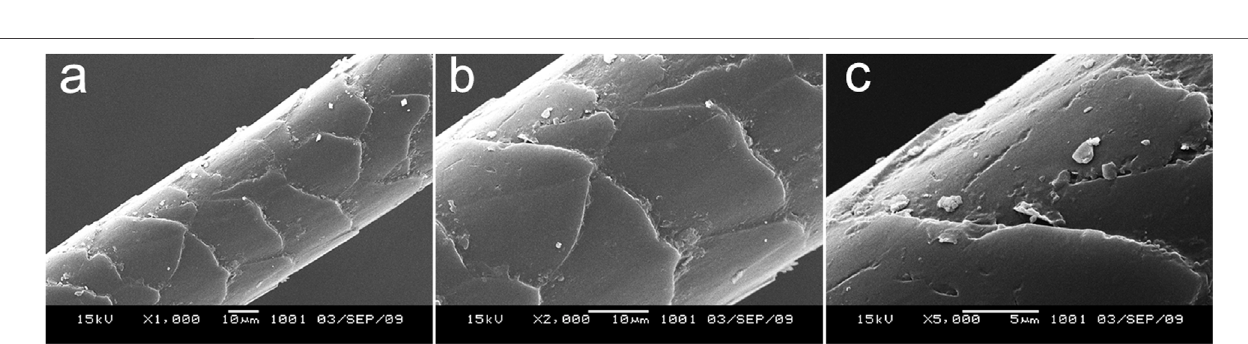
FIGURE 2 | Polar bear hair surface structure by SEM with different magni fi cations (A) ×1,000, (B) ×2,000, and (C) ×5,000.